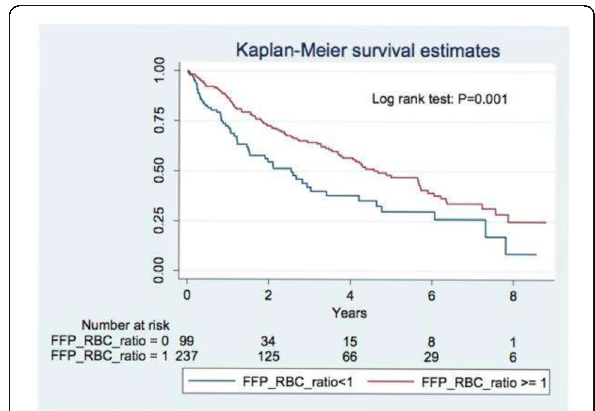
Fig. 1 (abstract 0253). Kaplan Meier Curve demonstrating survival benefit with FFP:RBC ratio